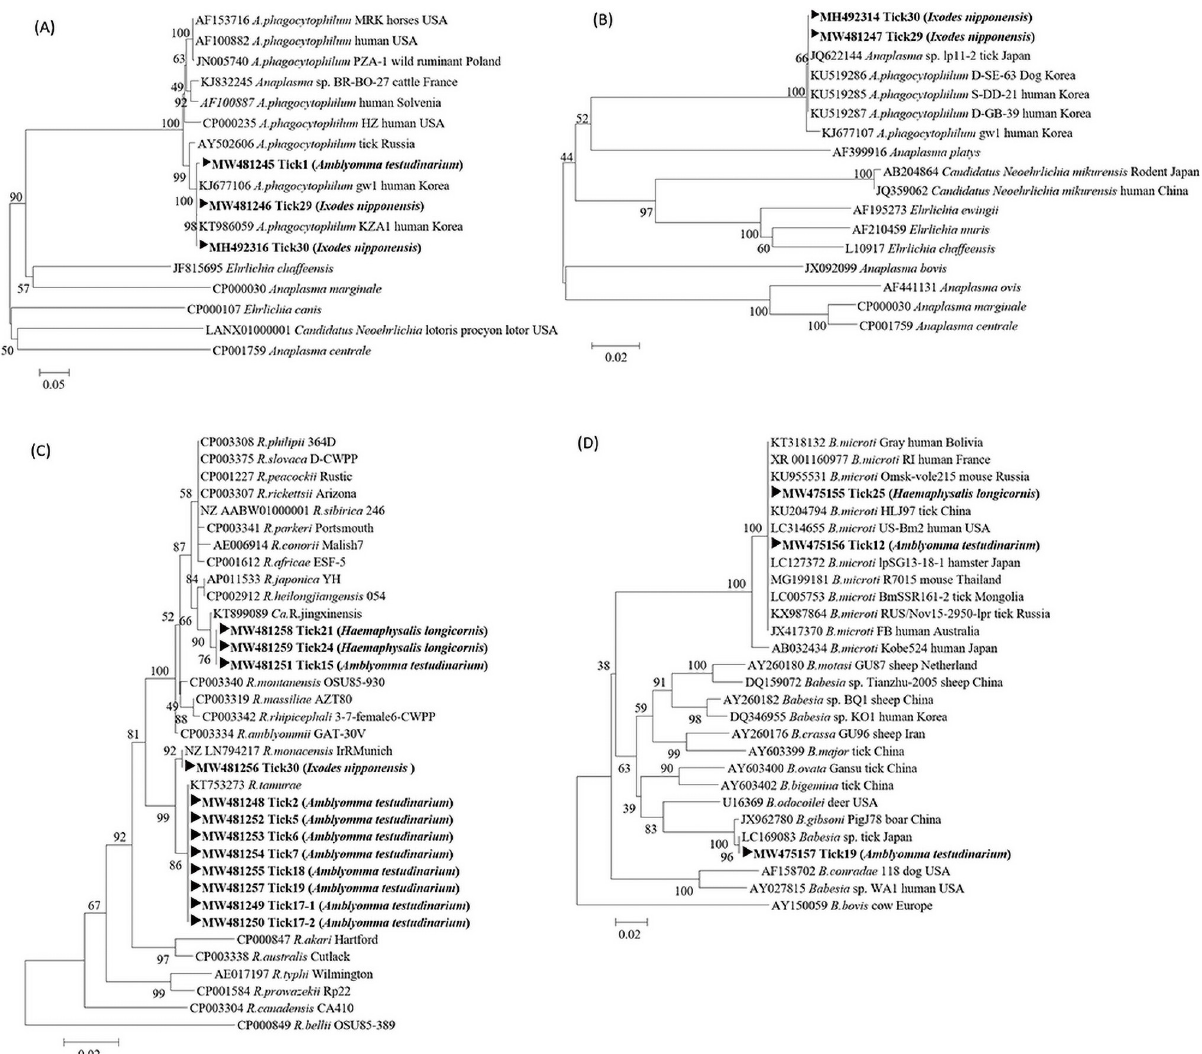
Fig 1. Phylogenetic trees based on partial nucleotide sequences obtained from A . phagocytophilum- , spotted fever group Rickettsia- , and Babesia - positive ticks in this study and from GenBank. (A) 560 bp portion of the ankA gene, (B) 330 bp portion of the groEL gene sequences for A . phagocytophilum , (C) 420 bp portion of the gltA gene sequences for SFG Rickettsia , and (D) 370 bp portion of the 18S rRNA gene sequences for Babesia species.